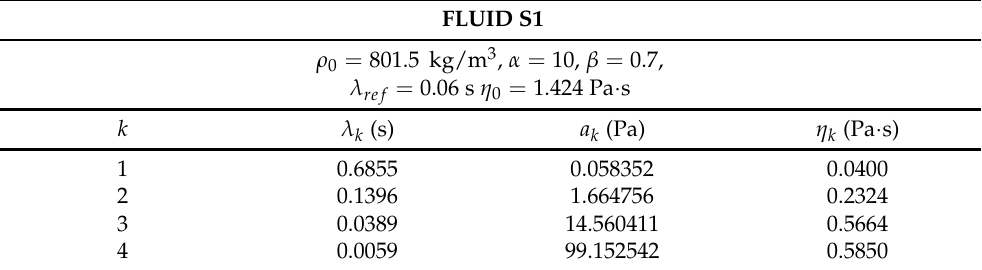
Figure 4. Dimensionless representation of the channel domain. Table 2. Fluid parameters used in this work. Adapted from [15].